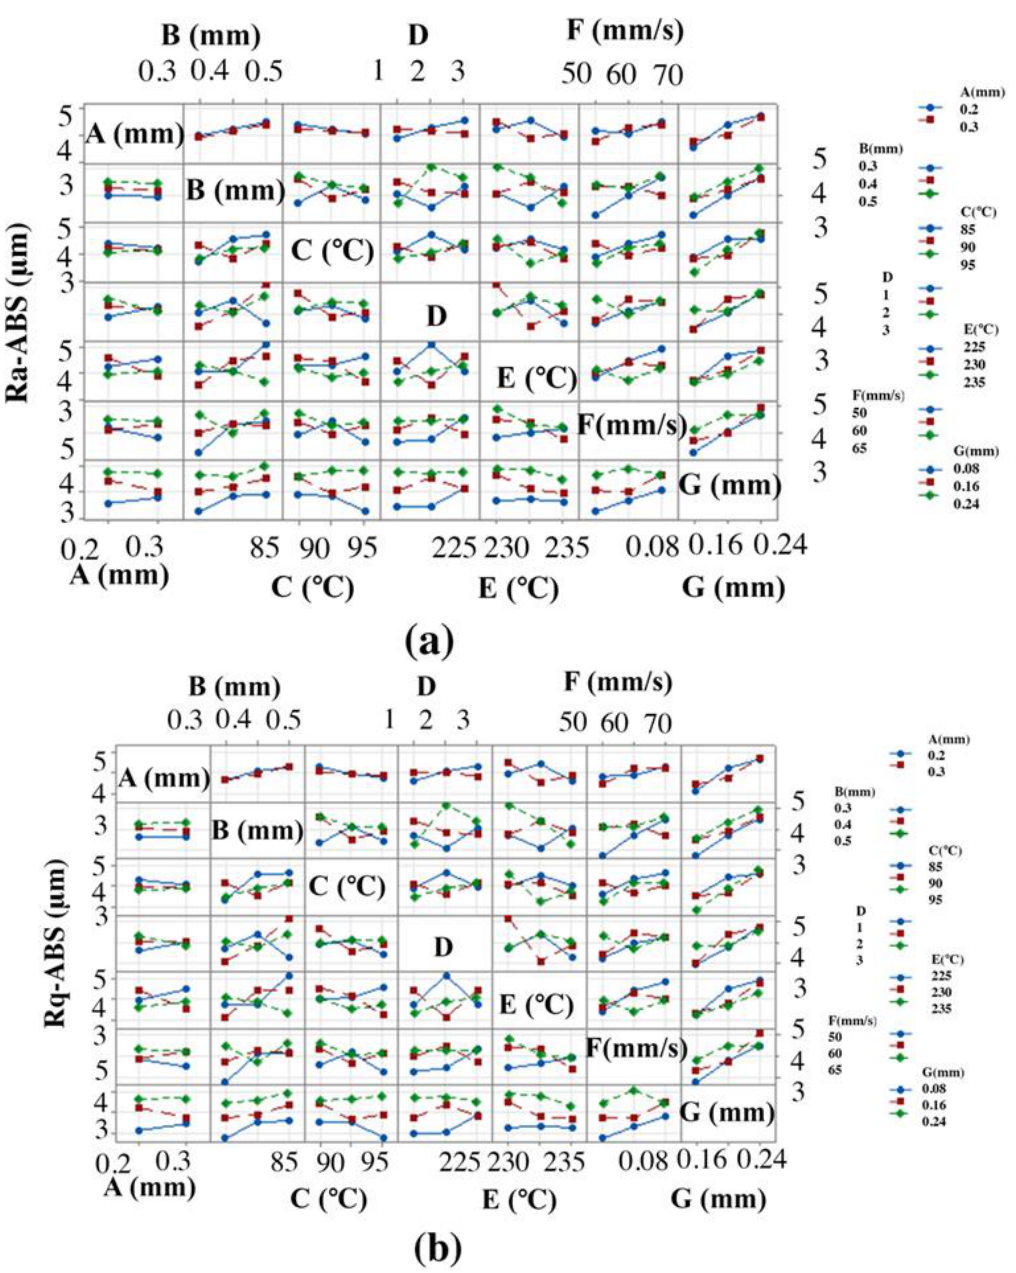
Figure 9. Effect of parametric interactions on polymers: ( a ) Ra-PA-6 and ( b ) Rq-PA-6.